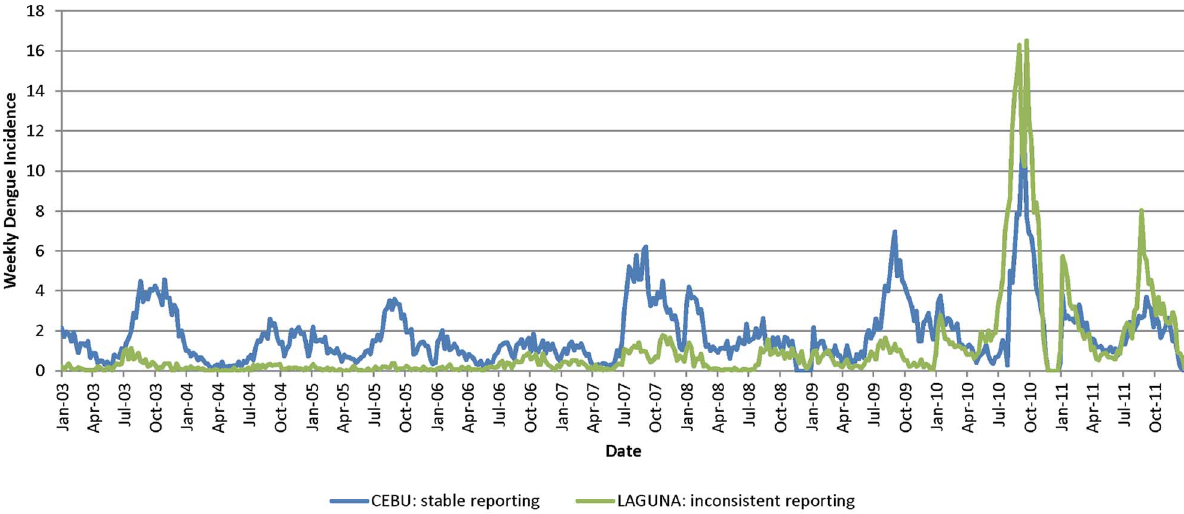
Figure 1. Weekly incidence for Cebu and Laguna provinces.